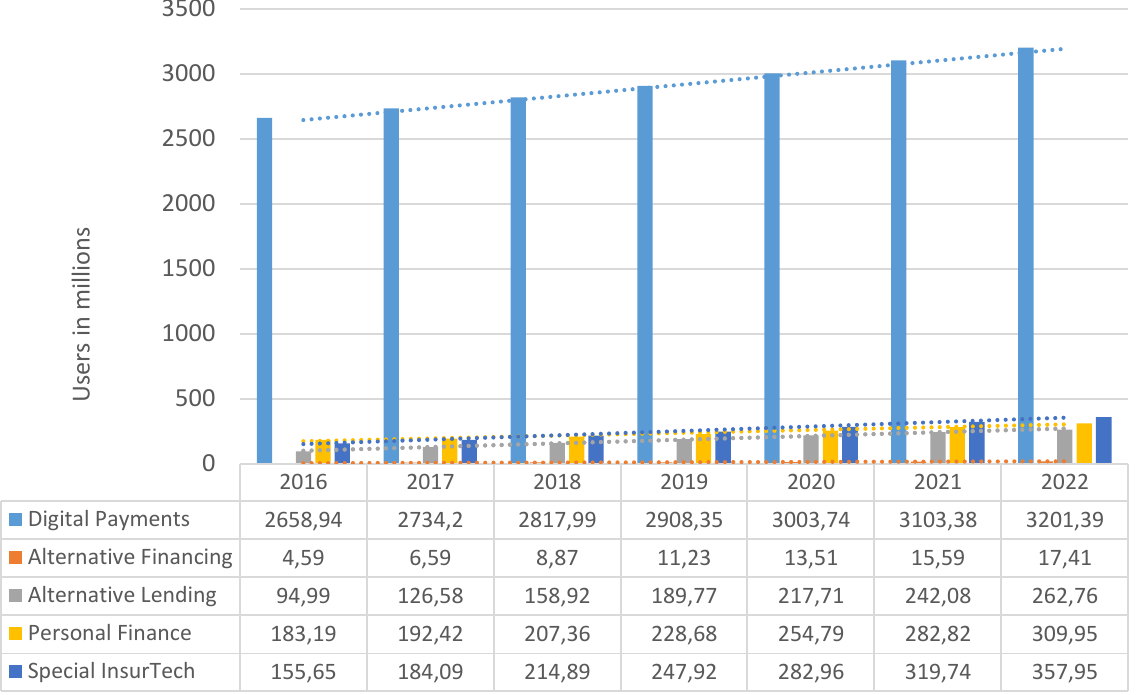
Figure 1. Number of users of products of financial technologies for the period